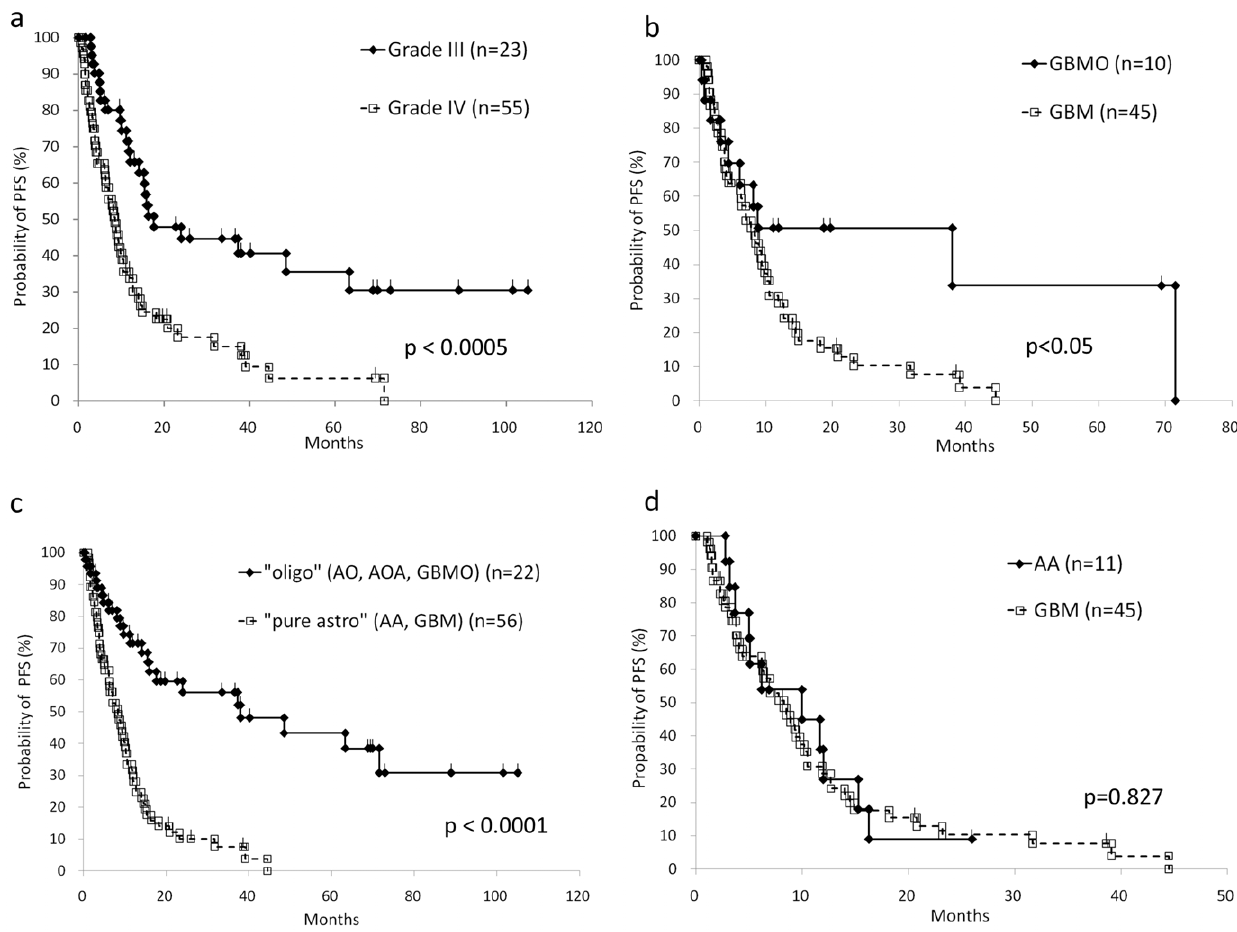
Figure 3. Progression-free survival (PFS) analysis based on the histological subclassifications. a: Conventional Grade III gliomas (AA, AO, AOA) show significantly longer PFS than Grade IV gliomas (GBM, GBMO). b: A significantly longer PFS in GBMO patients was observed compared to GBM (p=0.0456), while the OS was not significant (Fig. 2b). c: Oligodendroglial tumor (‘‘oligo’’; AO, AOA, GBMO) shows significantly longer PFS compared to pure astrocytic tumor (‘‘pure astro’’; AA, GBM). d: The PFS curve of AA patients is almost identical to that of GBM